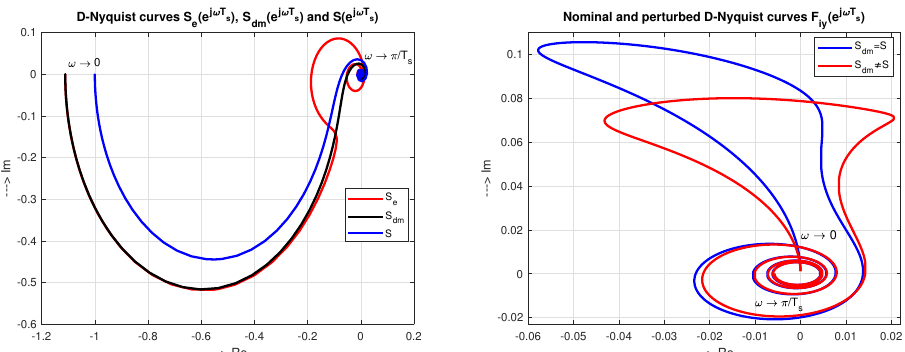
Figure 10. Nyquist curves of the equivalent plant S e ( z ) (Equation (44)), of the delay-free model S m ( z ) (3) and of the plant S ( z ) corresponding to S ( s ) = e − 0.1 s / ( s − 1 ) and S dm ( s ) = e − 0.07 s / ( s − 0.9 ) with T s = 0.01 and of the disturbance responses F iy ( z ) (Equations (41) and (45)); z = e j ω T s , ω ∈ ( 0, π / T s )